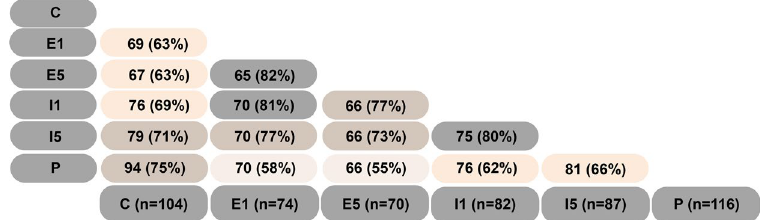
Figure 3. Venn diagram of the immunoprecipitated proteins identified using mass spectrometry. Number of co-identified proteins corresponding to number of autoantibodies and percentages of similarity are shown in the treatment groups; control (C), placebo (P), IFN- β on day 1 (I1), IFN- β on day 5 (I5), etomoxir on day 1 (E1) and etomoxir on day 5